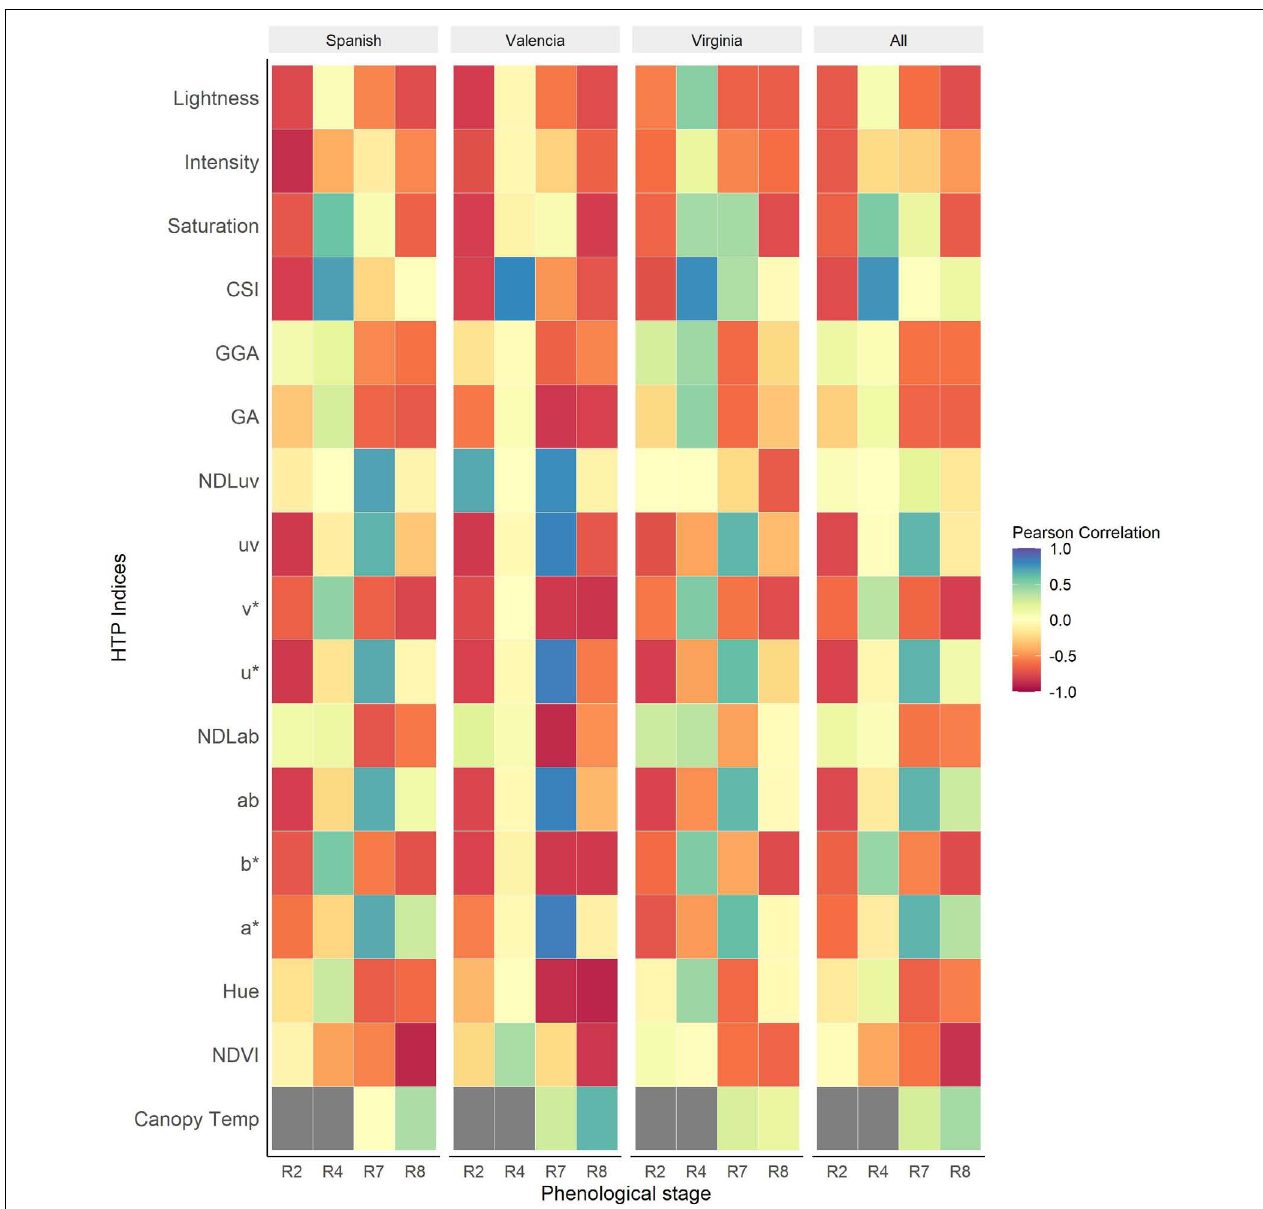
FIGURE 4 | Heatmap of Pearson correlations between HTP derived indices and visual scores of Late leaf spot (LLS) severity at different phenological stages of the growth season for the individual market types and all the market types analyzed together. The dark gray boxes represent missing